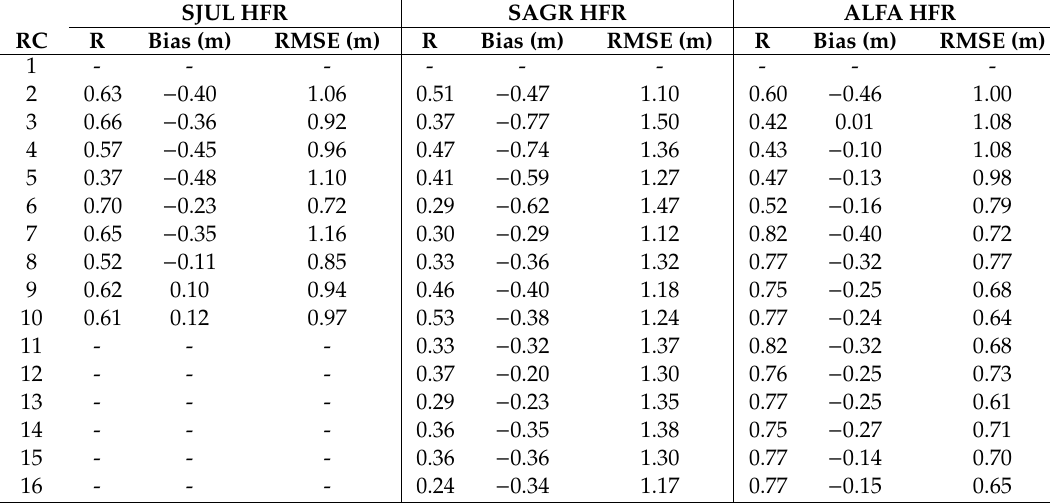
Table A5. Correlation (R), bias and RMSE (statistic metrics) between SRAL and HFR SWH for each RC, considering the distance from the coast; 12–13.5 MHz HFR sites (SJUL, SAGR and ALFA).